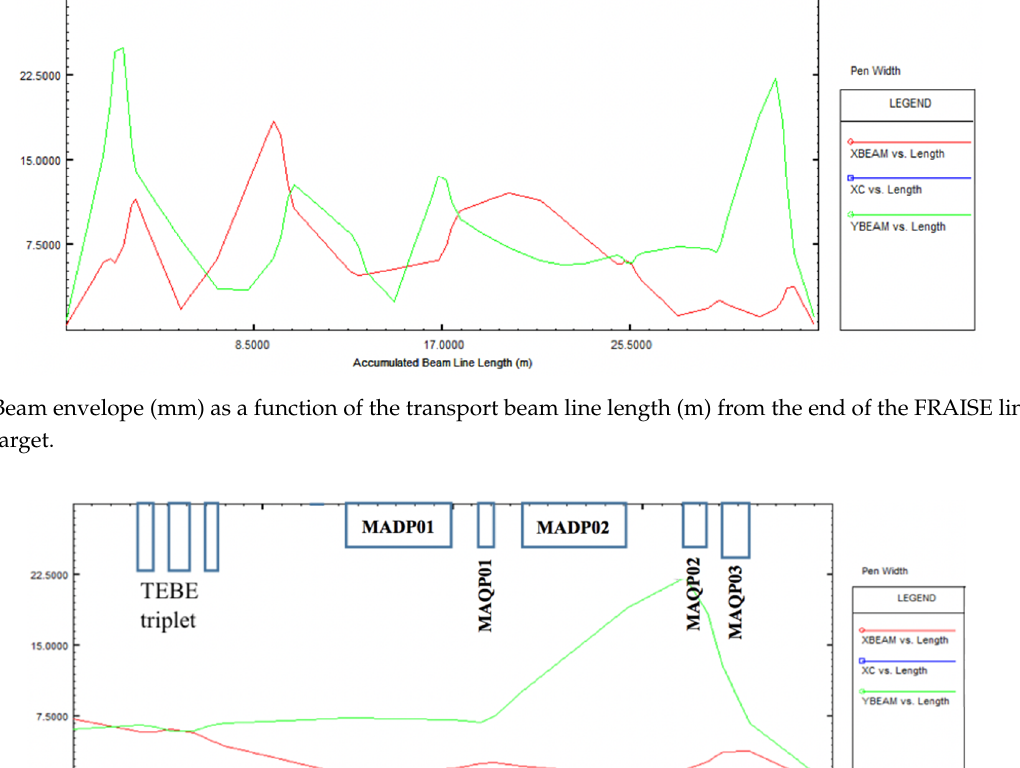
Figure 3. Layout of the new MAGNEX experimental area.